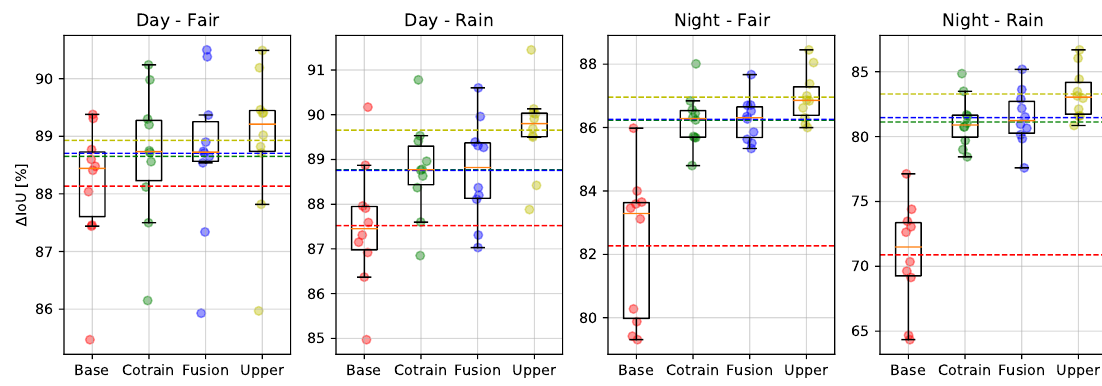
Figure 3. Performance distribution over the networks’ cross-validation on data splits; a detailed description can be seen in Section